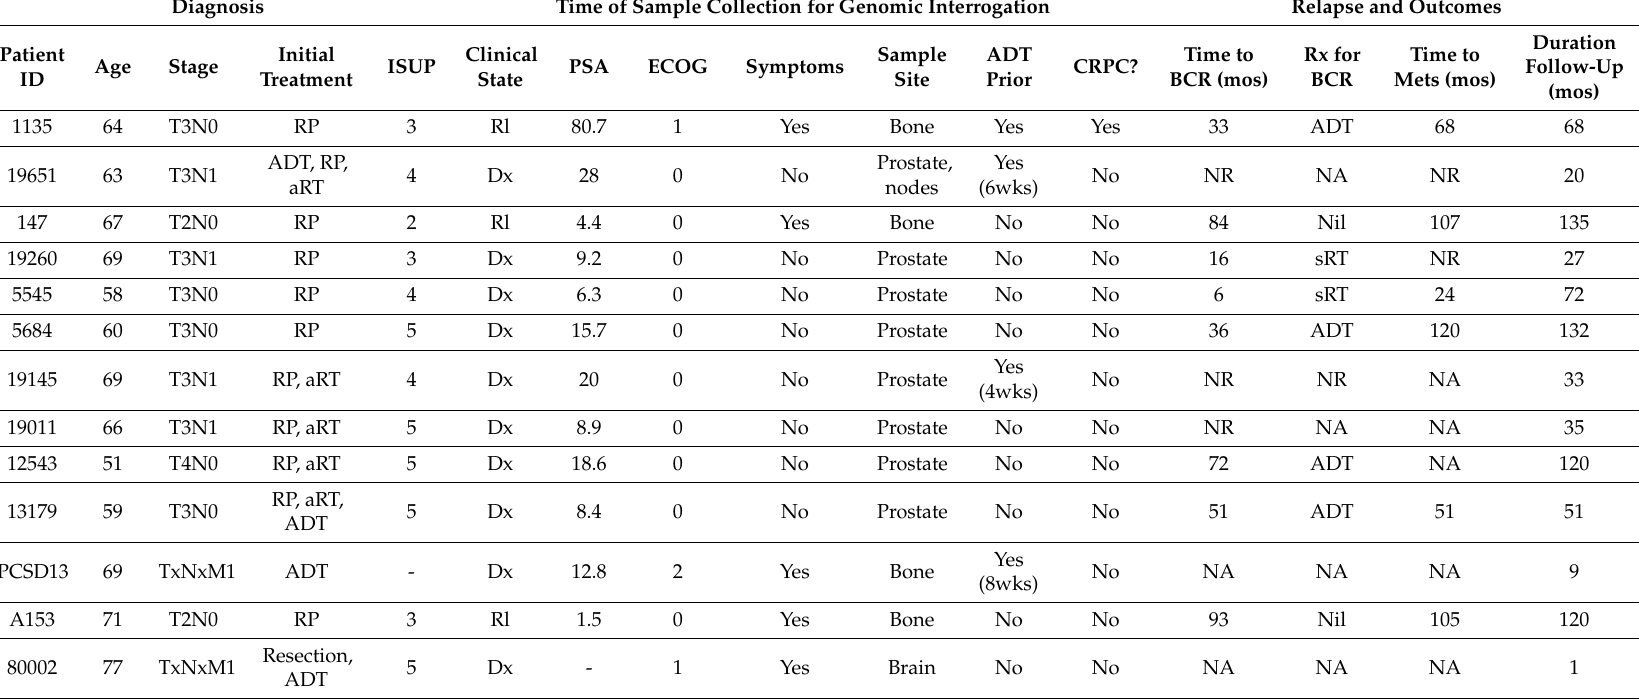
Table 1. Clinical and pathological